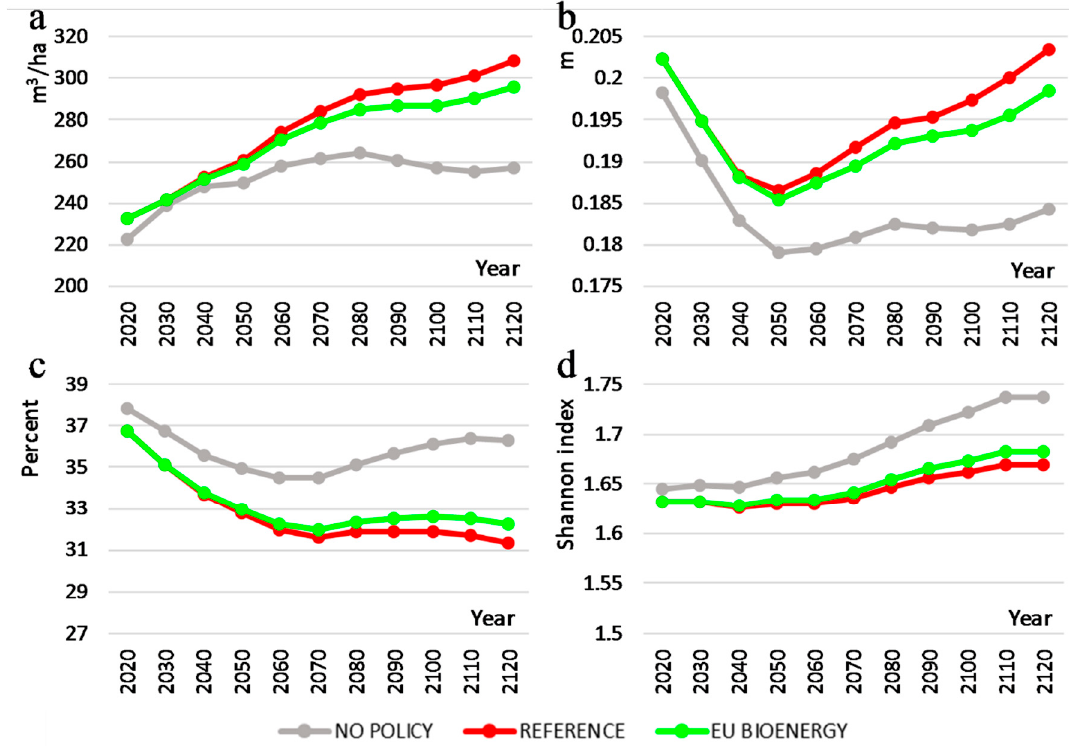
Figure 4. Selected attributes of Lithuanian forests at specific time points, depending on future scenarios: ( a ) Standing volume in 1 ha, ( b ) average diameter of all forest stands, ( c ) relative share of broadleaved tree species in the standing volume, and ( d ) tree species diversity.